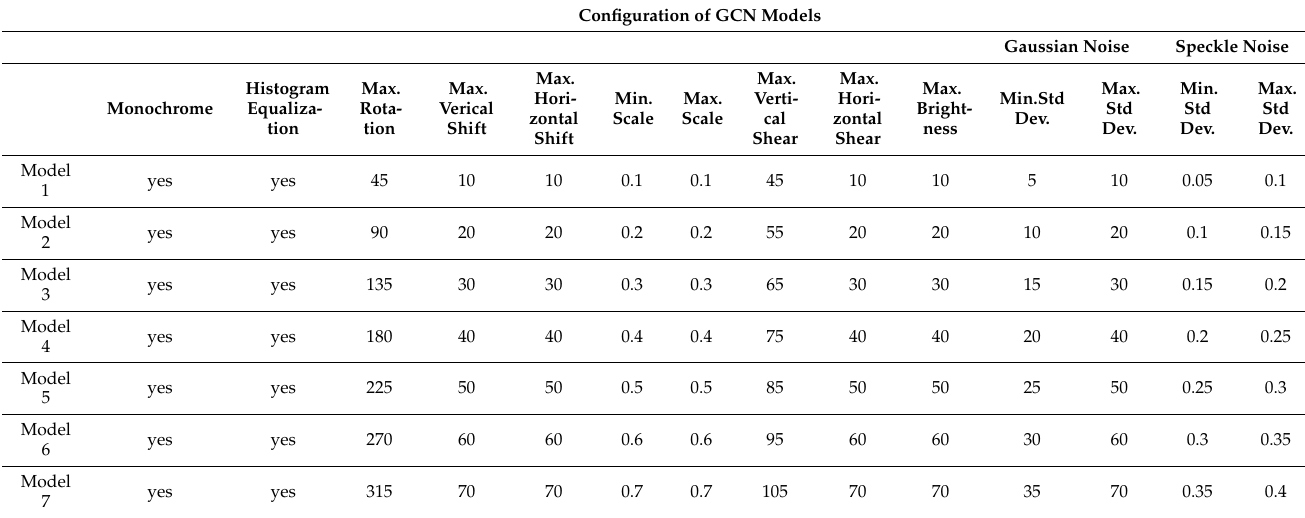
Table 1. Comparison of different GCN models configuration.